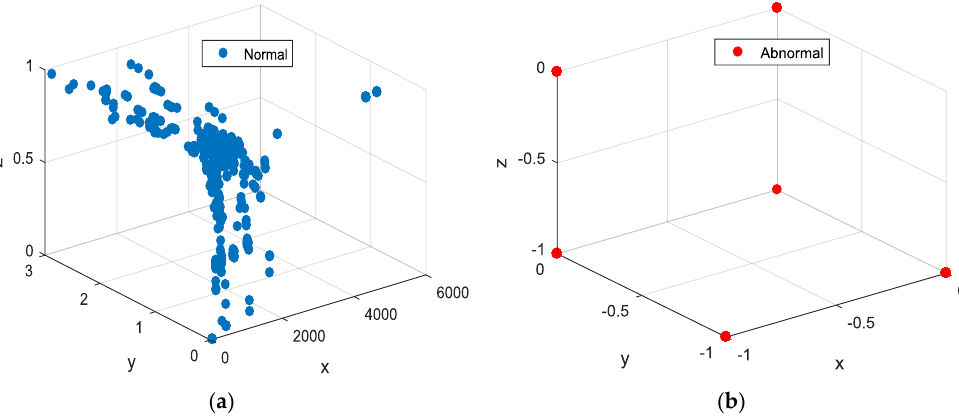
Figure 11. Normal data distribution and abnormal data distribution. ( a ) Normal data; ( b ) Abnormal data.